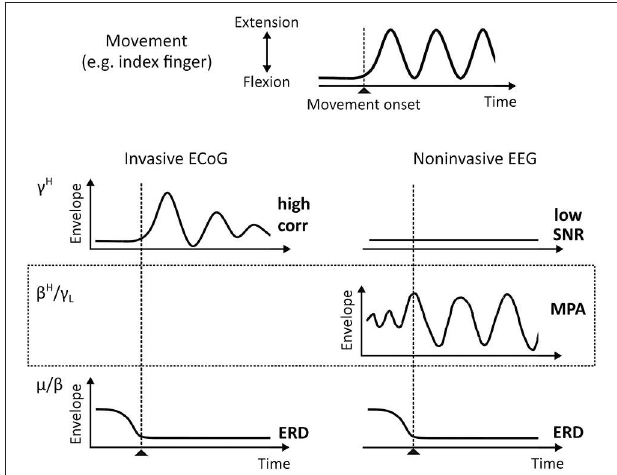
FIGURE 1 | ECoG and EEG envelopes of known oscillatory phenomena during single-trial motor behavior (idealized). The top plot shows a typical times series recorded from data glove sensors during, for example, index finger extension and flexion movements. Below characteristic γ H (70–150 Hz) and µ/β (8–12 Hz/13–30 Hz) activities for invasive ECoG and noninvasive EEG, respectively, are shown. EEG β H - γ L (24–40 Hz) MPA is shown in the dotted box. corr , Pearson Correlation Coefficient; ERD, Event-Related Desynchronization; MPA, Movement Phase related Amplitude